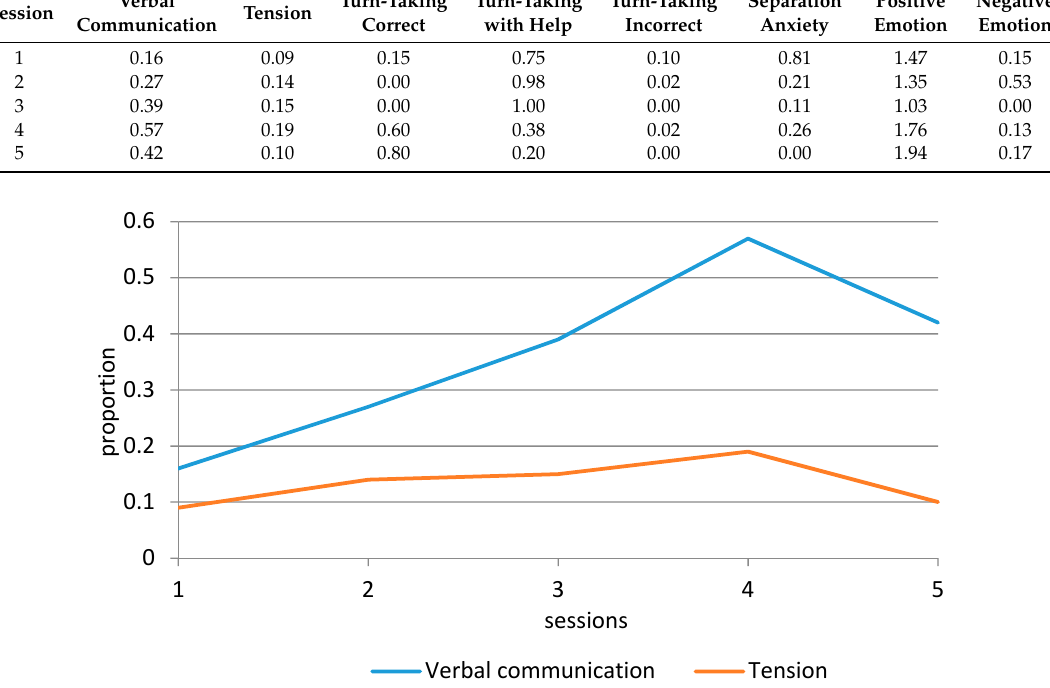
Figure 1. Graphical display of the participant’s verbal communication and tension over time.